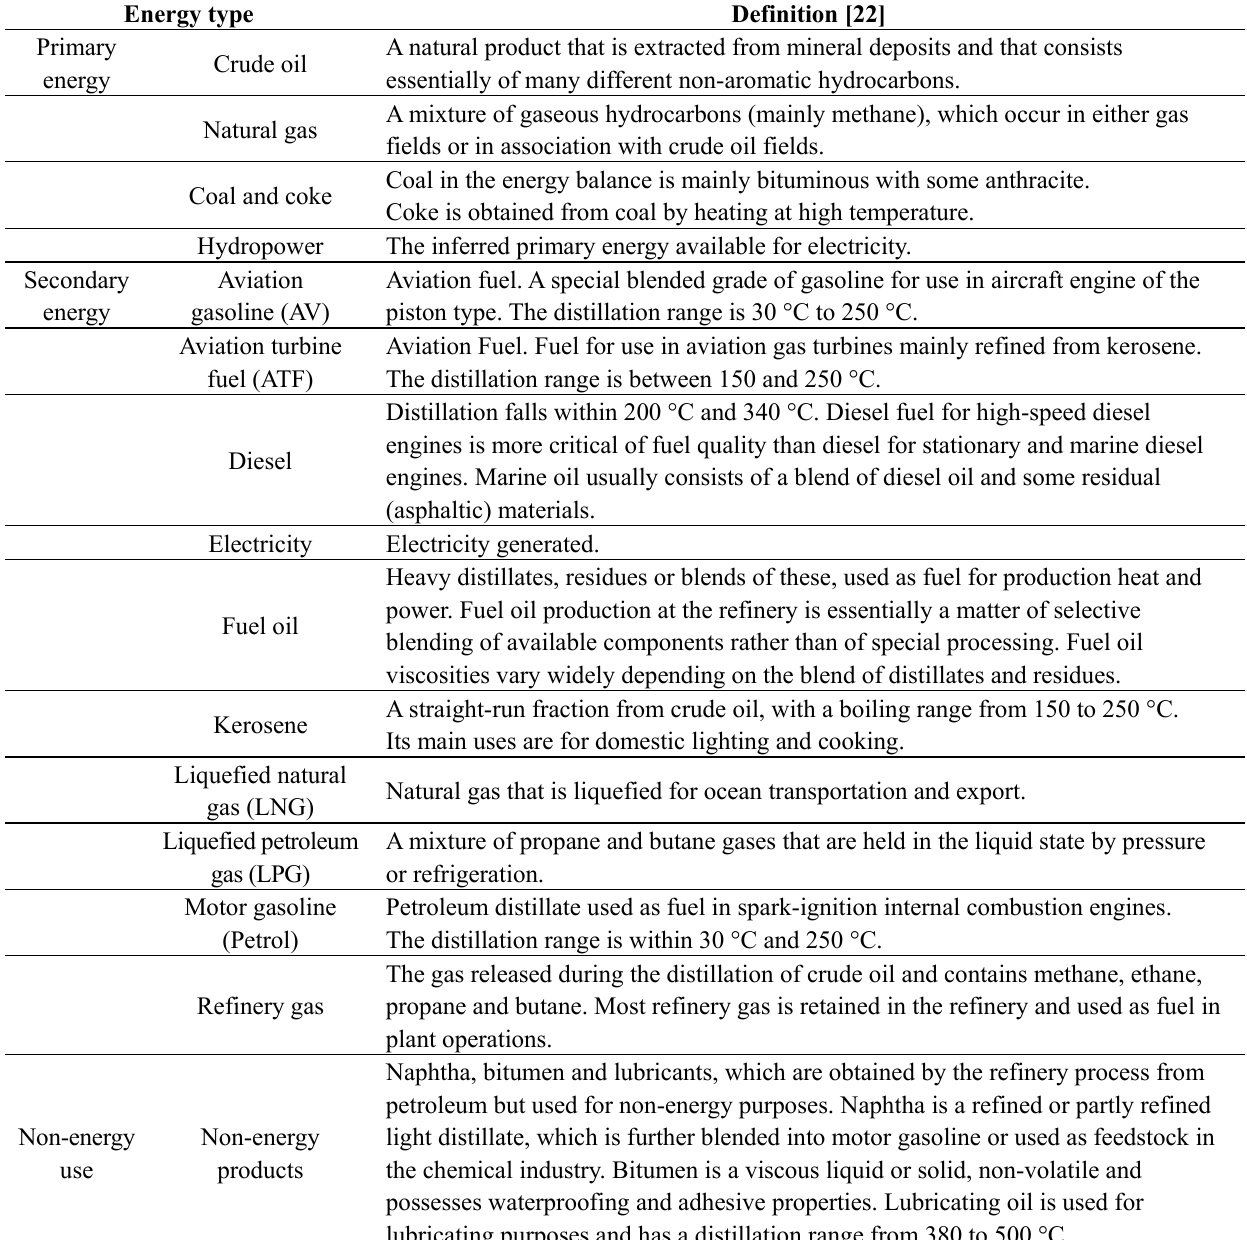
Table 2. Main energy types considered in the